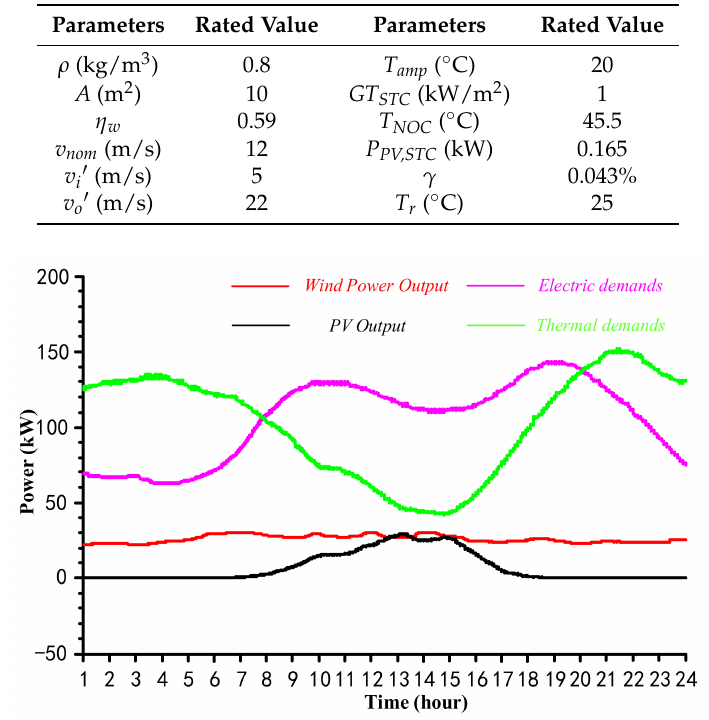
Table 2. Portable energy system data sheet.